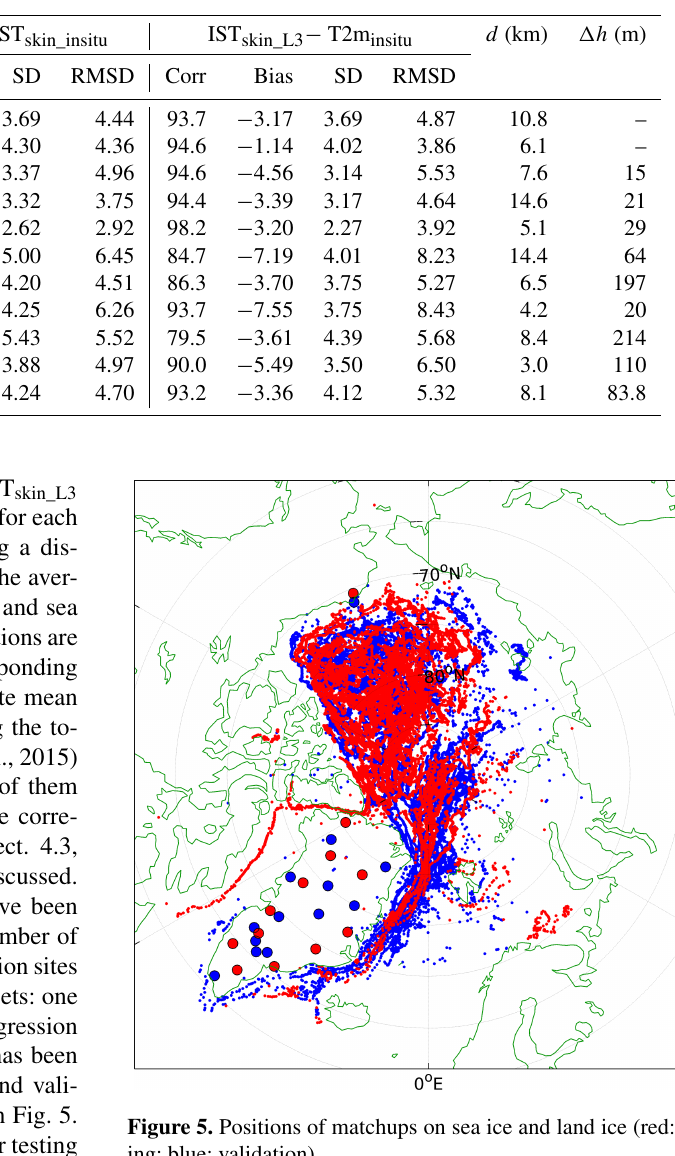
Table 2. Validation of daily AASTI v.1 Level 3 IST (IST skin_L3 ) against in situ IST skin (IST skin_insitu ) and T2m observations (T2m insitu ). N : number of matchups; Corr: correlation; SD: standard deviation; RMSD: root-mean-square difference. d is the matchup distance and (cid:49)h is the difference in elevation (AWS − satellite).